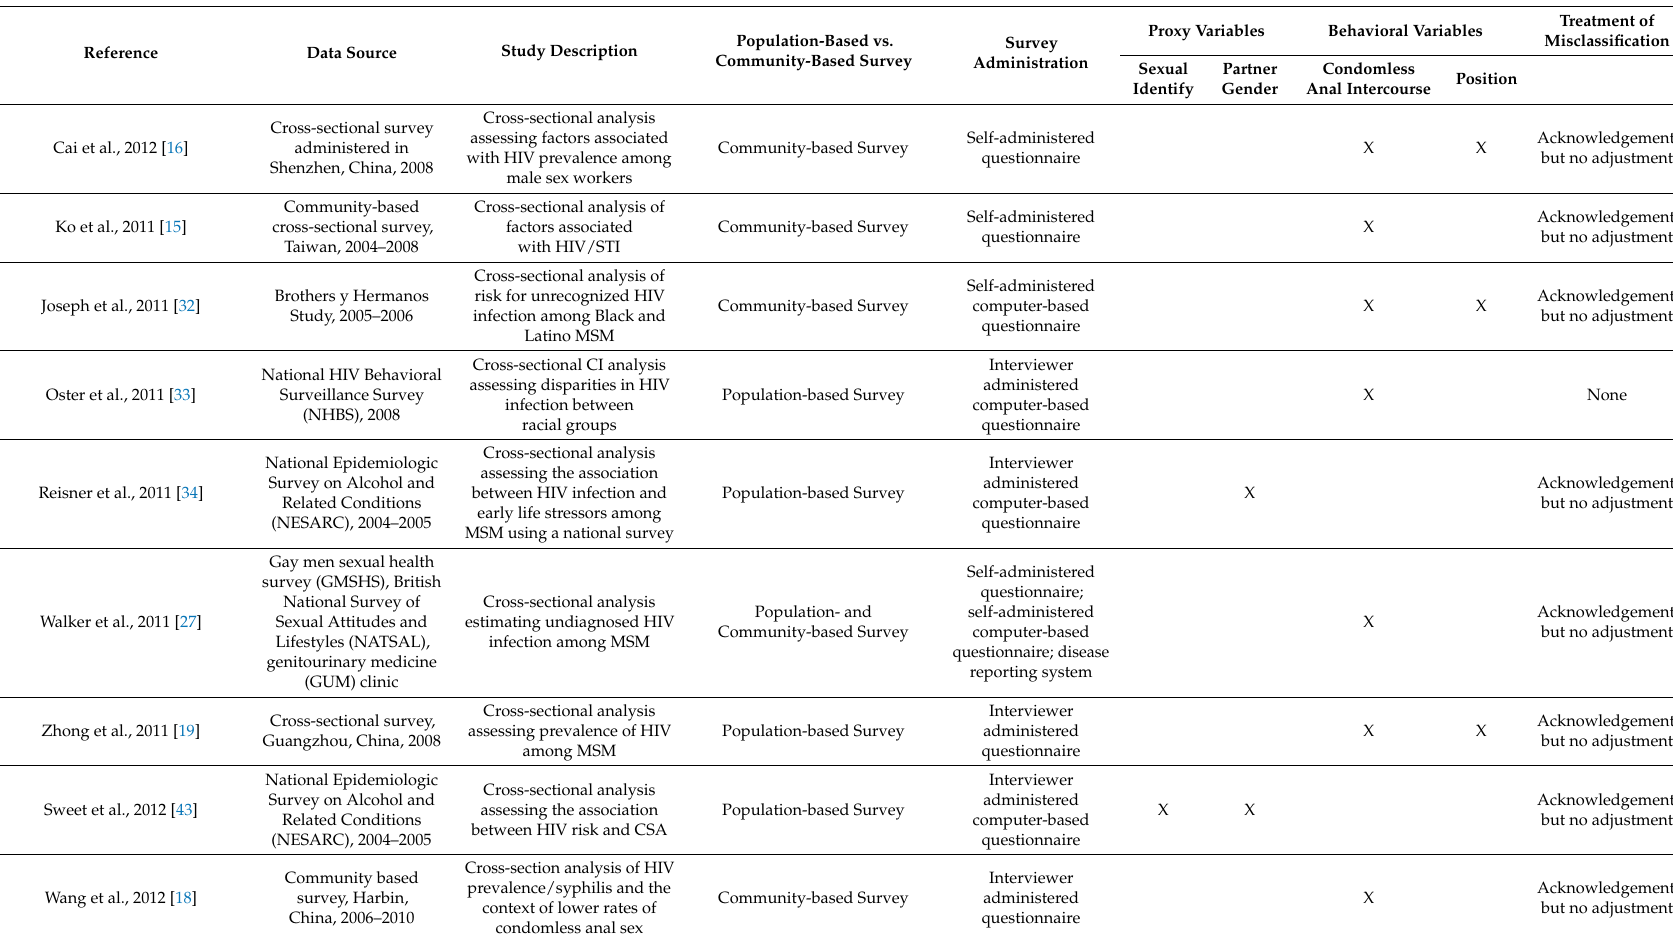
Table 1. Selected examples of HIV research among men who have sex with men (MSM) and adjustment methods for purported misclassification of sexual behaviors.